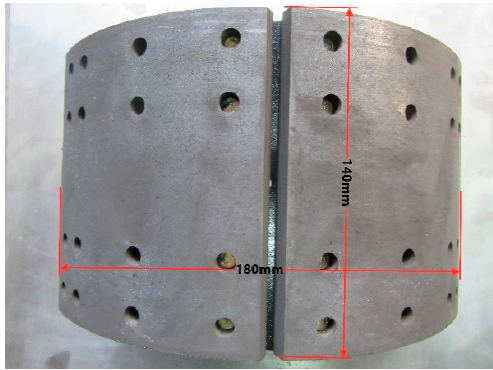
Figure 2. Semi-metallic brake pads.